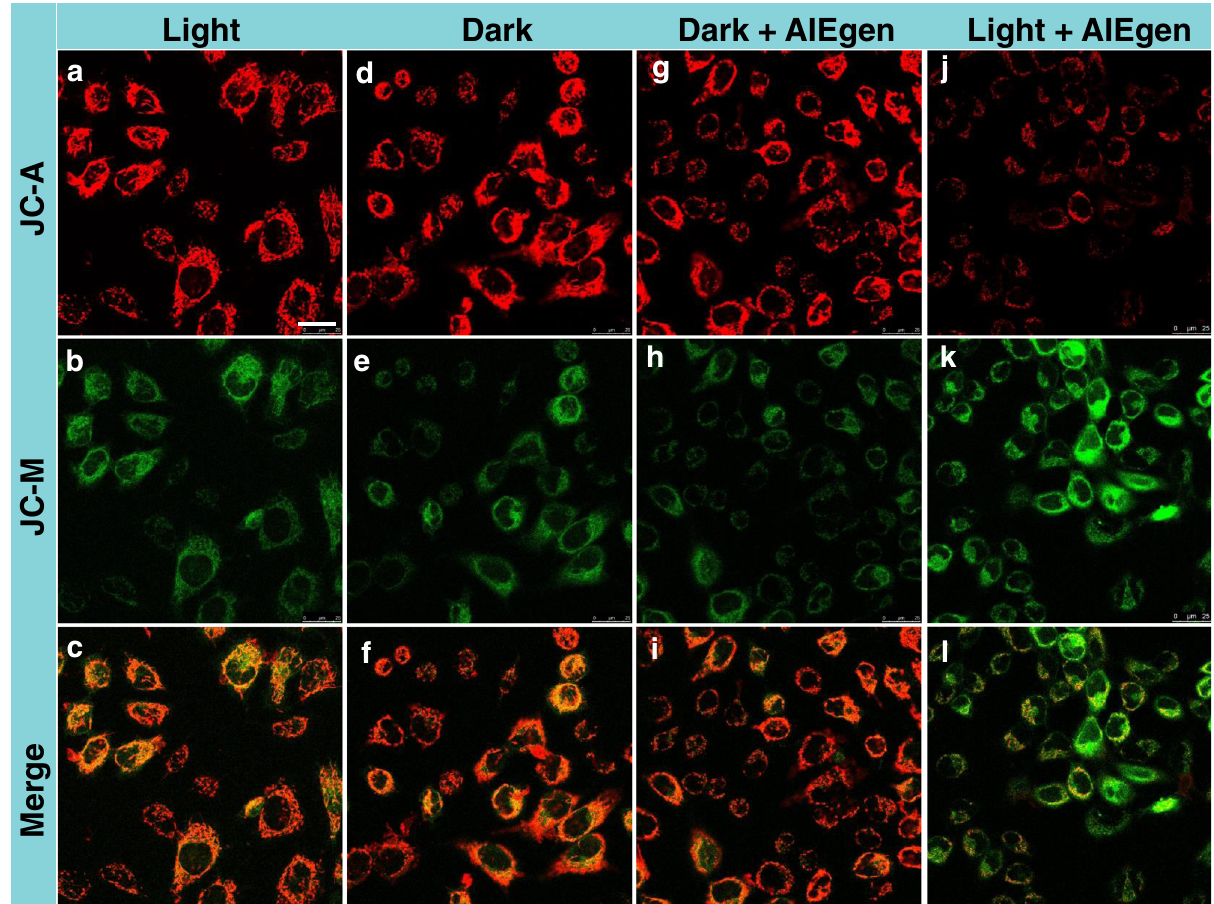
Fig. 8 Changes of mitochondrial membrane potential after PDT. CLSM images when HeLa cells performed with different conditions: ( a – c ) with light irradiation; ( d – f ) without light irradiation (control group); ( g – i ) in the presence of TPE-PyT-CPS (0.2 μ M) without light irradiation; ( j – l ) in the presence of TPE-PyT-CPS (0.2 μ M) with light irradiation (25 mWcm − 2 , 2 min). JC-1 was used as a mitochondrial membrane potential indicator. The experiments were performed three times independently, representative images are shown. Scale bar: 25 μ